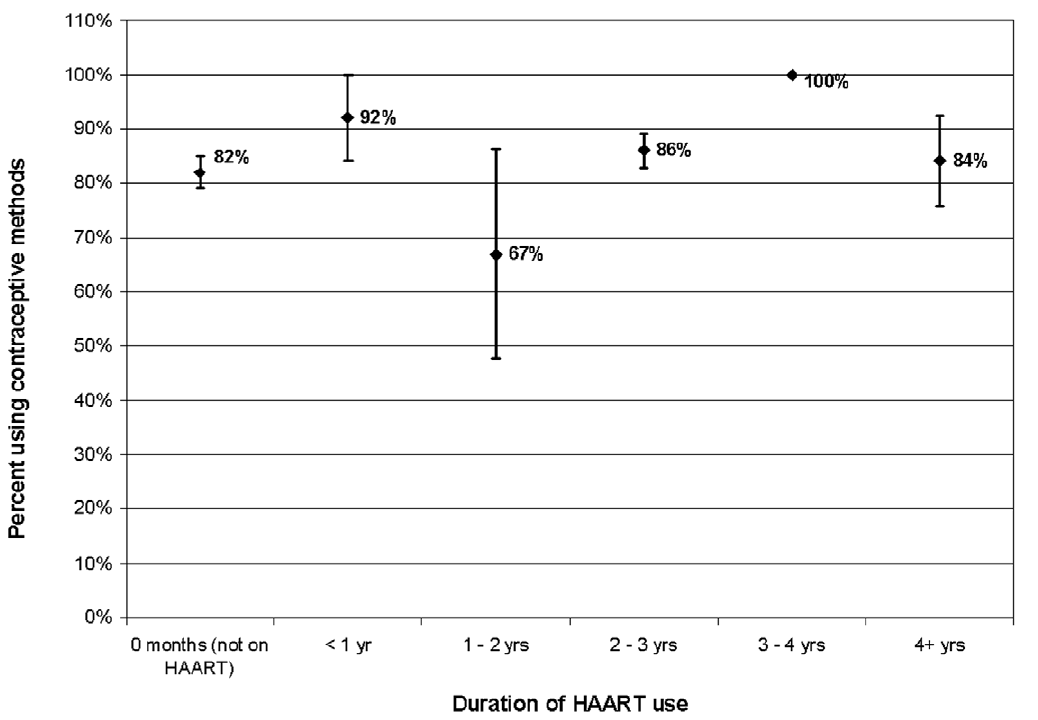
Figure 1. Percentage of HIV-positive women using contraception, by length of time on highly active antiretroviral therapy (HAART): Soweto, South Africa (n=349).